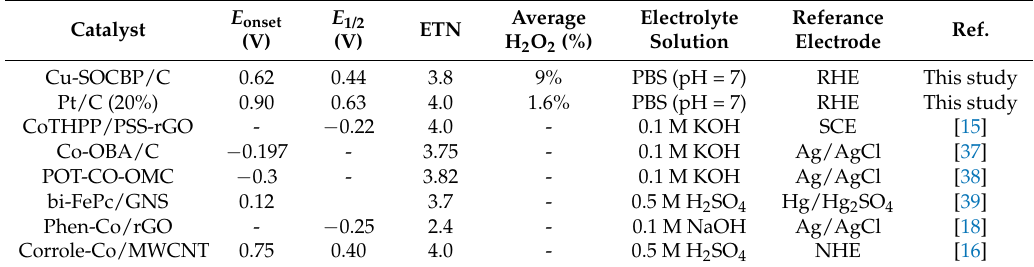
Table 1. ORR abilities of some M ‐ N x ‐ containing non ‐ noble catalysts reported in recent years. Catalyst